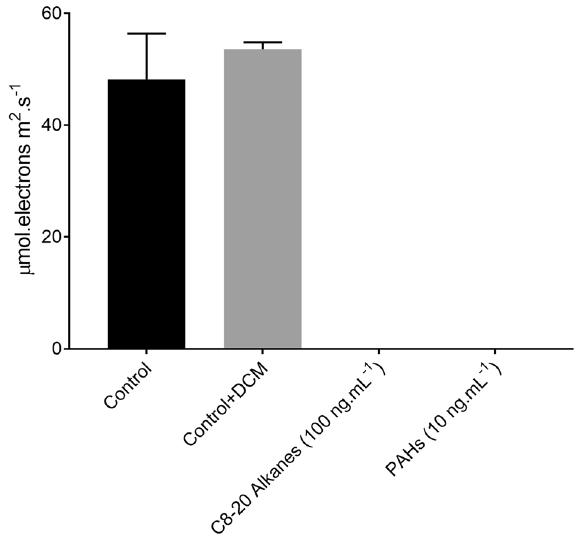
Figure 4. Effects of short-term exposure of alkane, PAH mix, and the solvent DCM on relative electron transport rates of T. pseudonana (± standard deviation) after 48 h of incubation under Control and WAF treatments (n = 3).